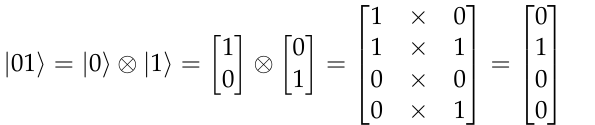
Figure 4. Circuit representation of the CX gate. In this case, q 1 will be flipped only if q 0 is | 1 (cid:105) . Quantum processing with multiple qubits is represented using tensored vectors. A tensored vector is the result of the tensor product (represented by the symbol (cid:78) ) of two or more vectors. A system of two qubits looks like | 0 (cid:105) ⊗ | 0 (cid:105) , but it is normally abbreviated to | 00 (cid:105) . It is useful to study the expanded form of the tensor product to follow how it works. For instance, see Equation